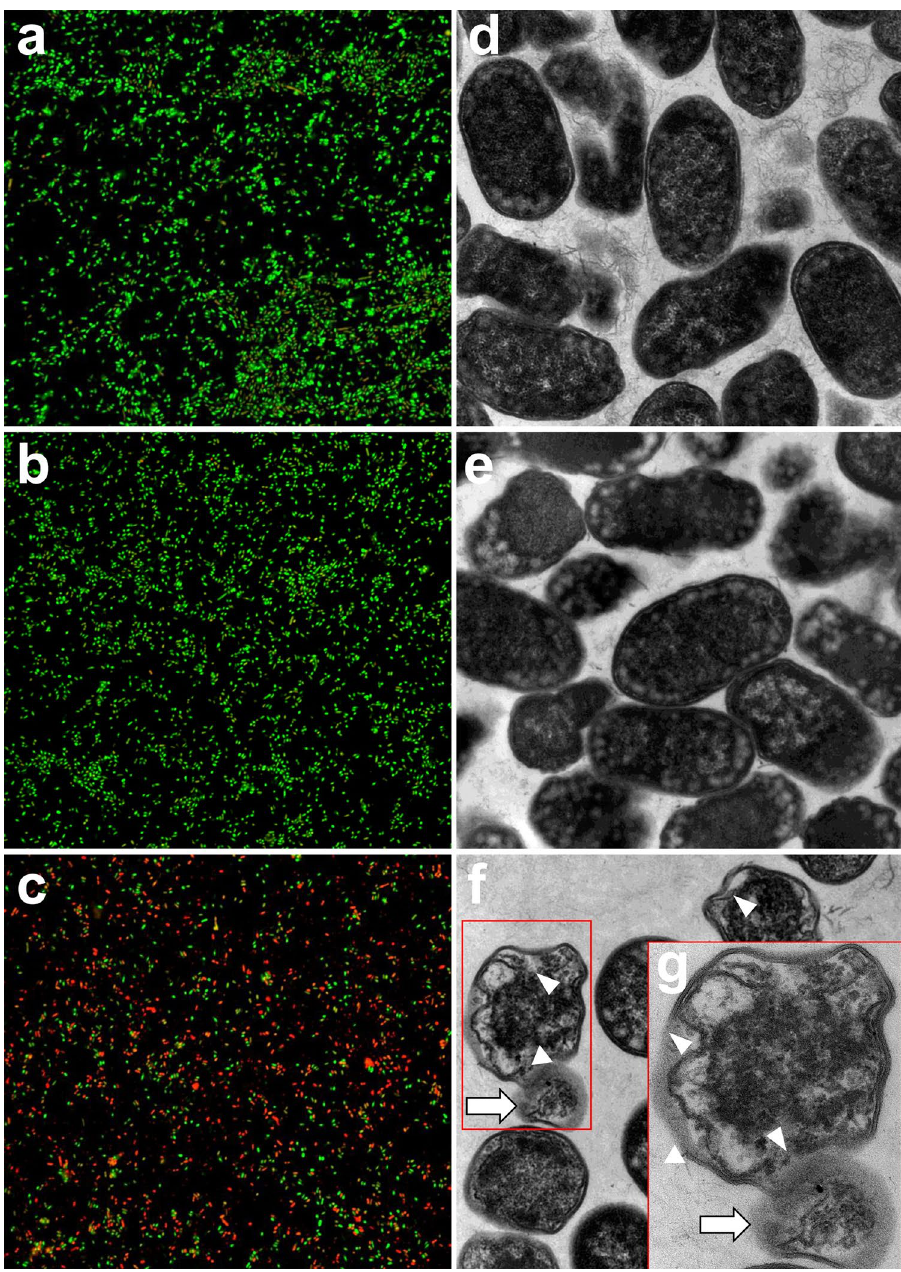
Figure 4. Morphological changes of Salmonella following incubation with NK2A and Sc-NK2A. Confocal laser scanning microscopy (CLSM) was performed to identify live (green, SYTO 9) and dead (red, PI) Salmonella . CLSM images of Salmonella outbreak isolate SX238 incubated with ( a ) PBS, ( b ) 5 µM Sc-NK2A, and ( c ) 5 µM NK2A. Transmission electron microcopy (TEM) was performed to visualize damage to the membranes of MDR Salmonella outbreak isolate SX238. TEM images of MDR Salmonella SX238 incubated with ( d ) PBS, ( e ) 20 µM Sc-NK2A, and ( f ) 20 µM NK2A ( d – f = 23,000 × magnification). Dead bacteria with damaged outer- and inner-membranes [( f and g ), white triangles], loss of normal bacterial morphology and cytosolic contents (g = 68,000 × magnification, white arrow) were visible only in NK2A treated samples. Representative images out of three independent experiments are